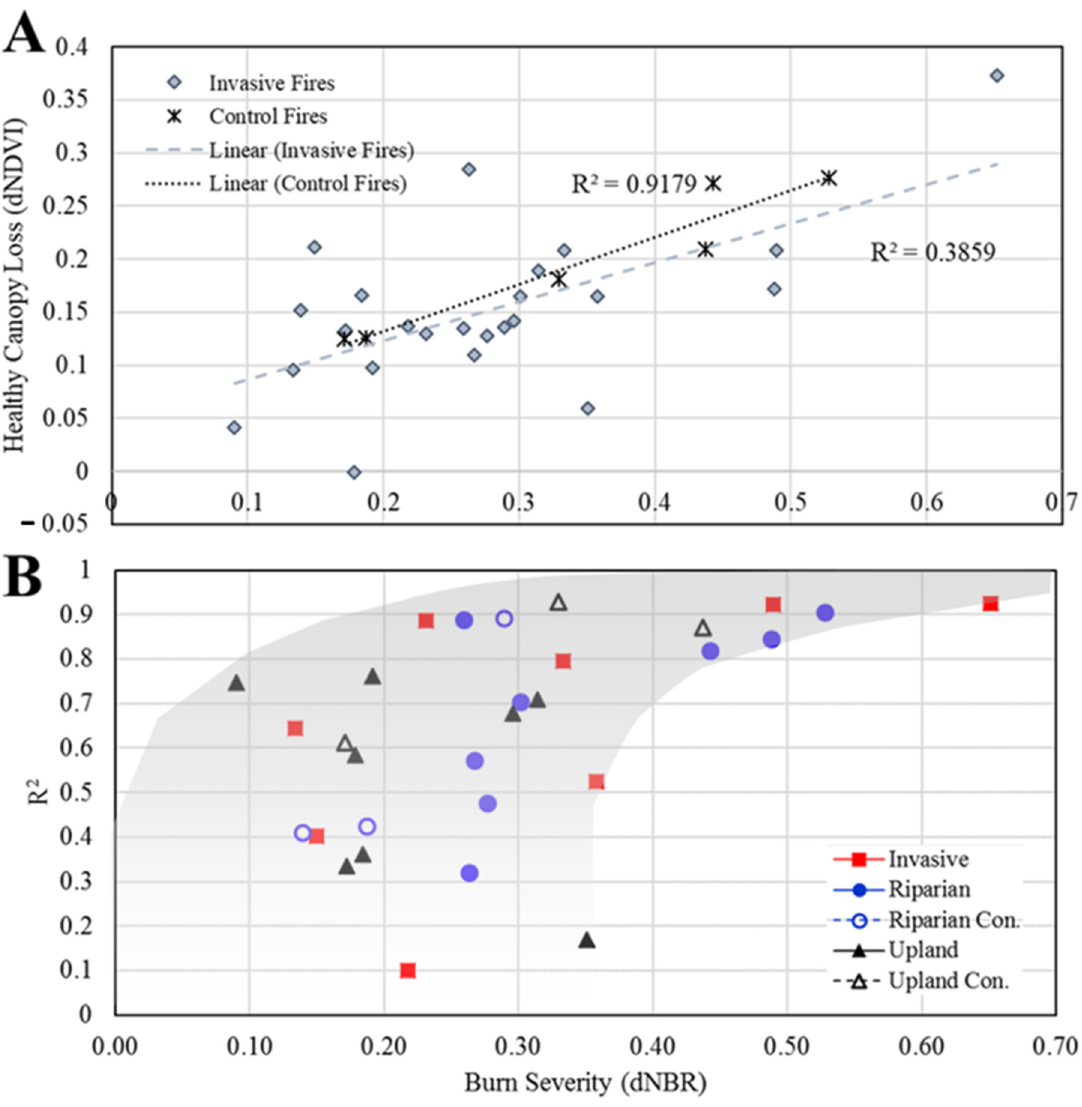
Figure 6. ( A ) The relation between average dNBR and dNDVI by class with respect to post-fire condition immediately after the fire (0-year). The regression equation and R 2 are denoted for invasive and control fires. ( B ) The average dNBR and R 2 by vegetation class with increasing burn severity. The grey shading highlights the approximate horizontal range of burn severity